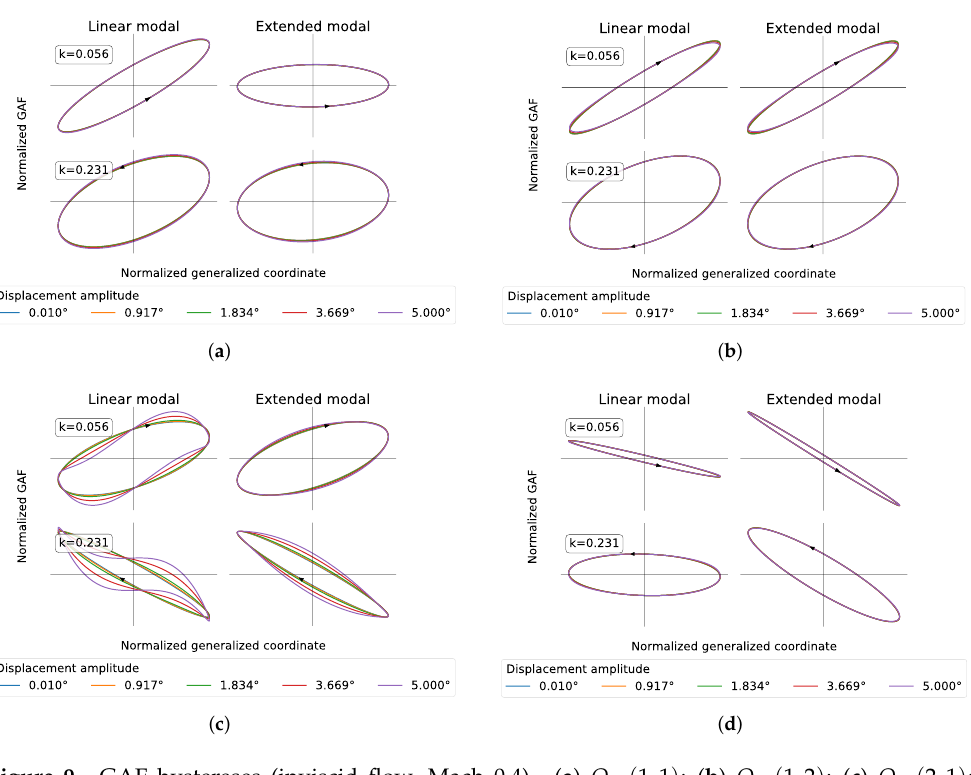
Figure 9. GAF hystereses (inviscid flow, Mach 0.4). ( a ) Q